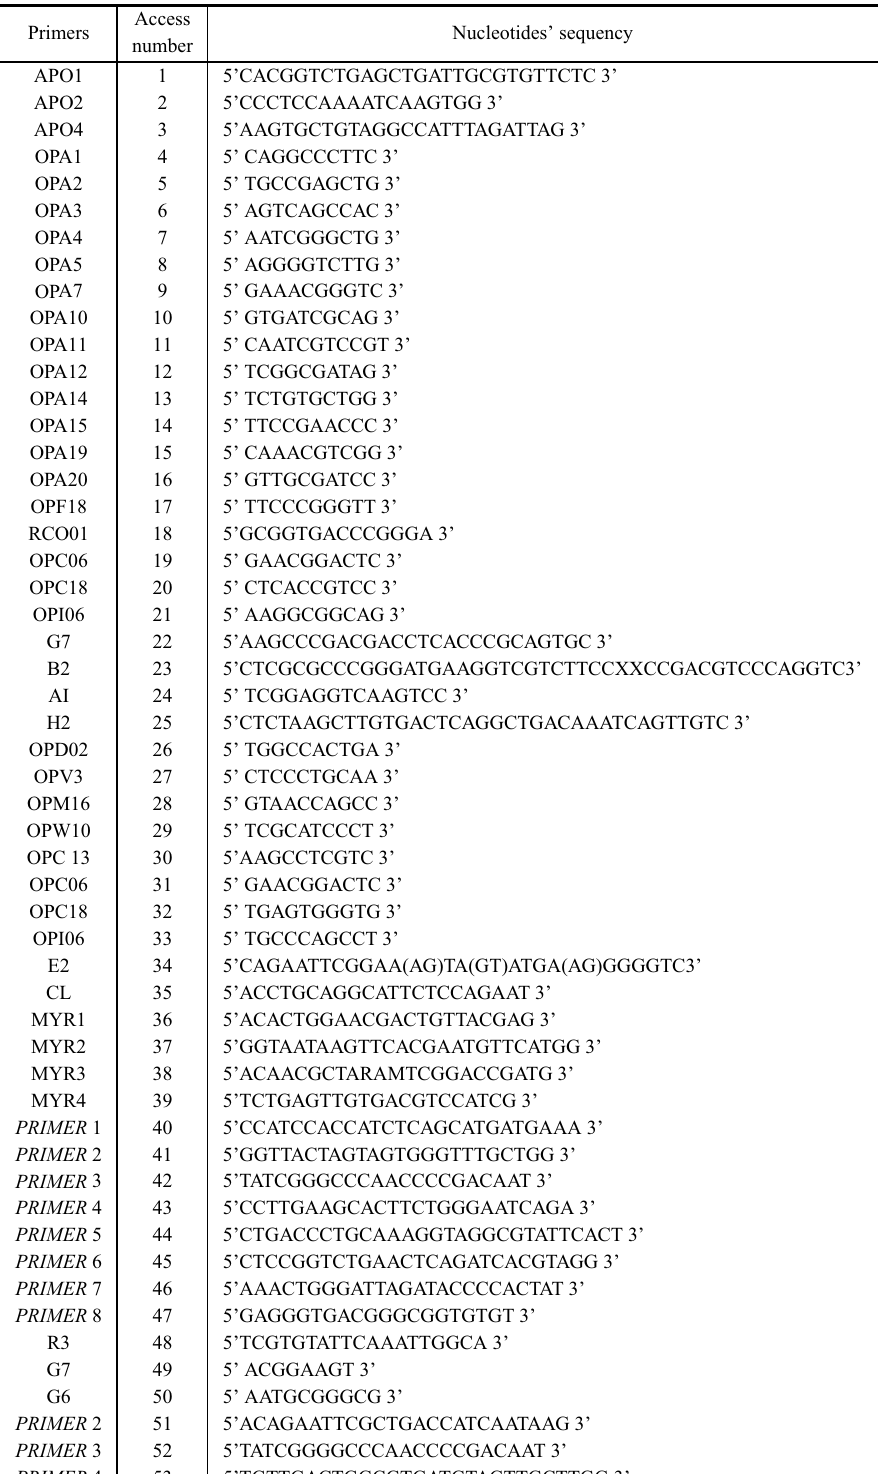
Primers used for the PCR reactions for the obtainment of RAPD